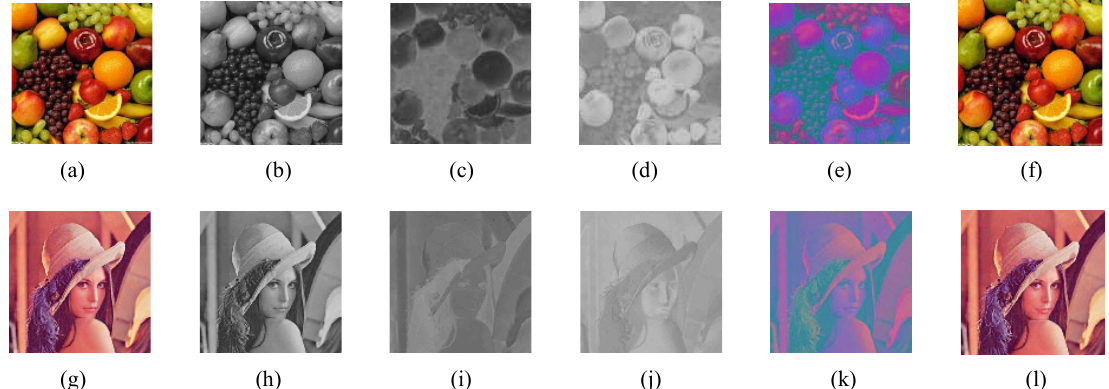
Fig. 5 Results of two color images decompressed using the JPEG technique: (a) the original color “Fruit” image, (b) – (d) decompressed Y, C b , and C r components of the “Fruit” image, respectively, (e) the color “Fruit” image reconstructed after decompression in the YC b C r color space, (f) the color “Fruit” image reconstructed after decompression in the RGB color space, and (g) – (l) corresponding to the results of (a) – (f) for “Lena” images,